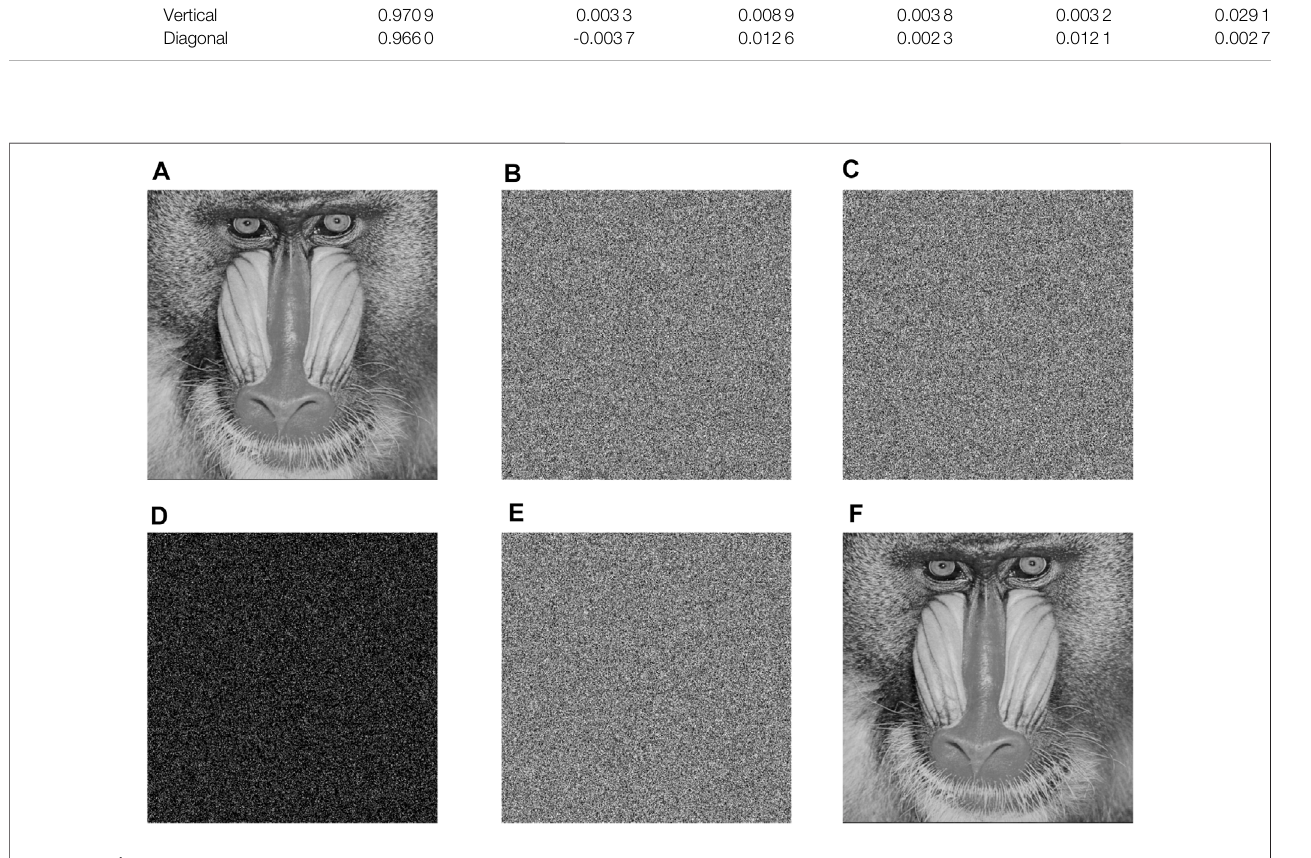
Frontiers in Physics |